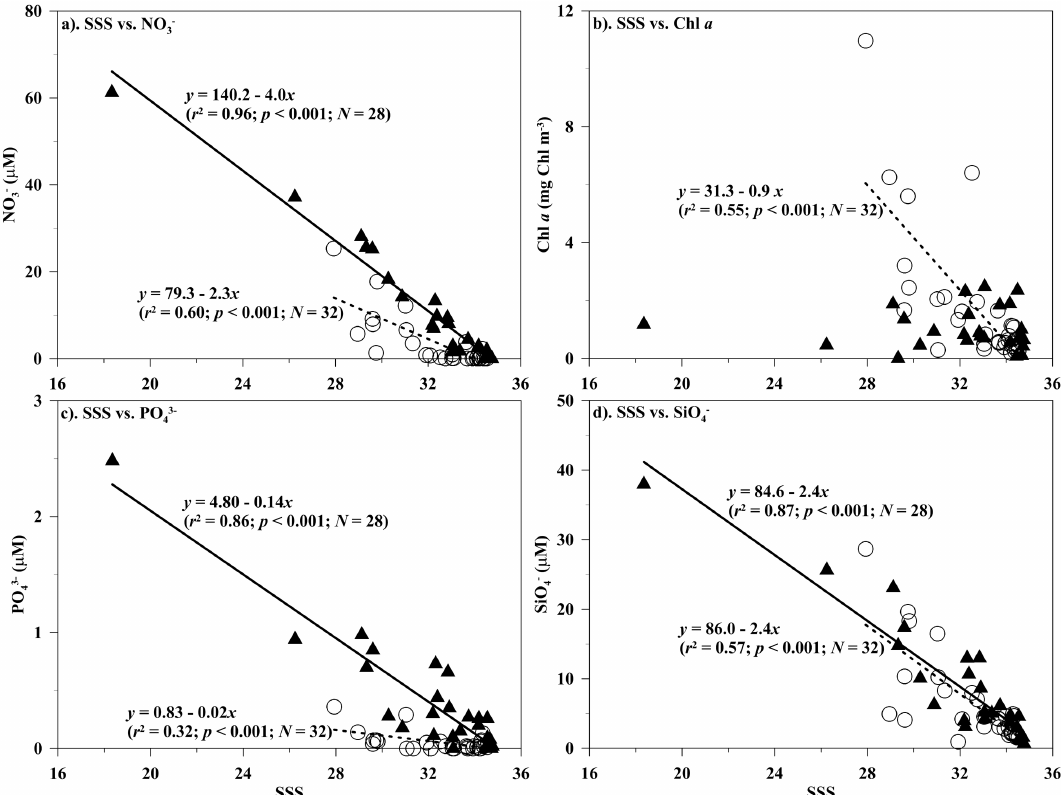
) , (b) chlorophyll a (Chl a) , (c) phosphate (PO 3 − 3